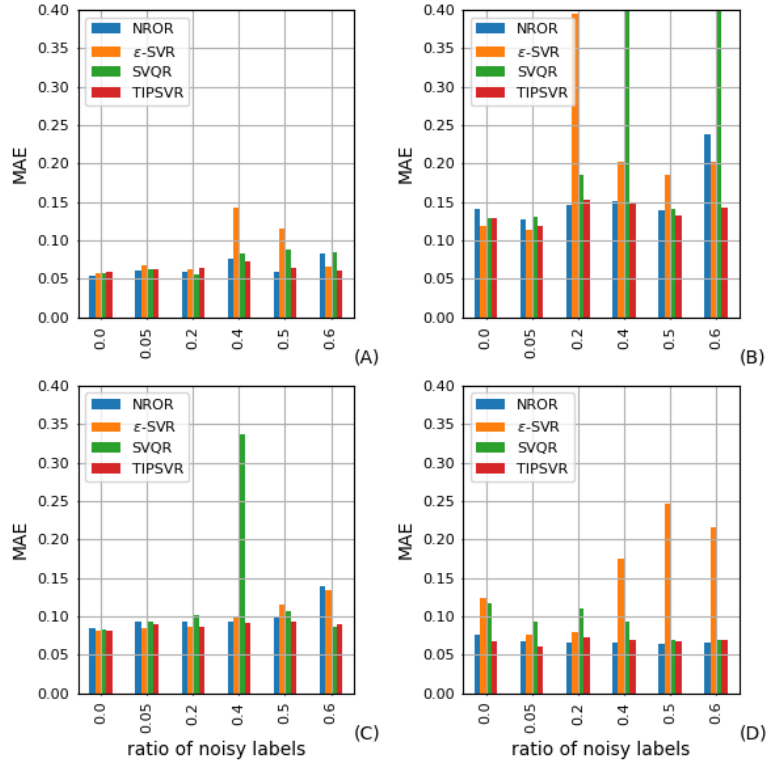
Figure 7. MAE for noise of heteroscedasticity on ( A ) CCPP, ( B ) DB, ( C ) EGSSD, ( D ) Abalone.